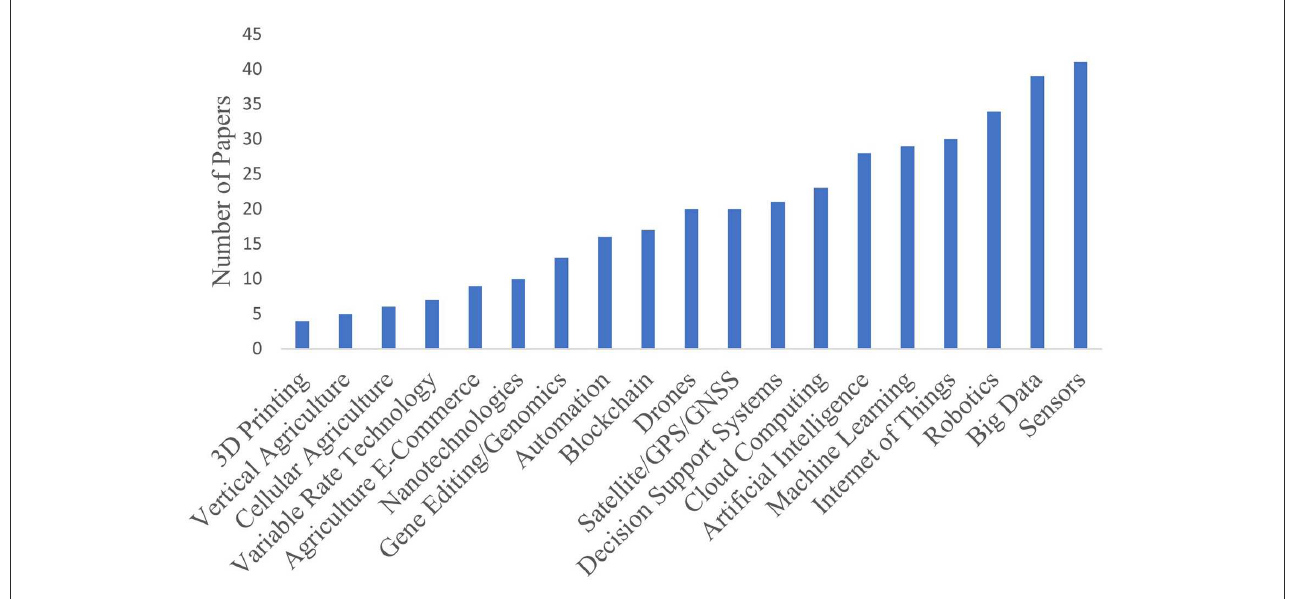
FIGURE2 Technologies mentioned as “digital agriculture” in review